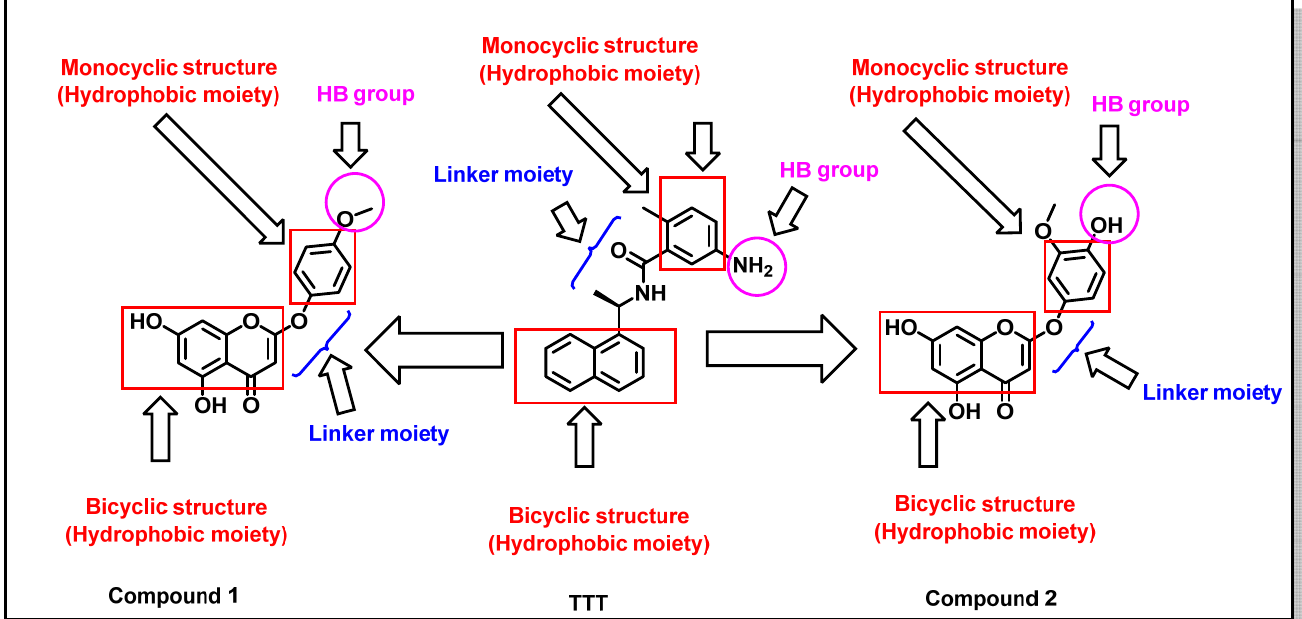
Figure 4. Compounds 1 and 2 have the same pharmacophoric features of the co-crystallized ligand of SARS CoV-2 PLP(TTT).